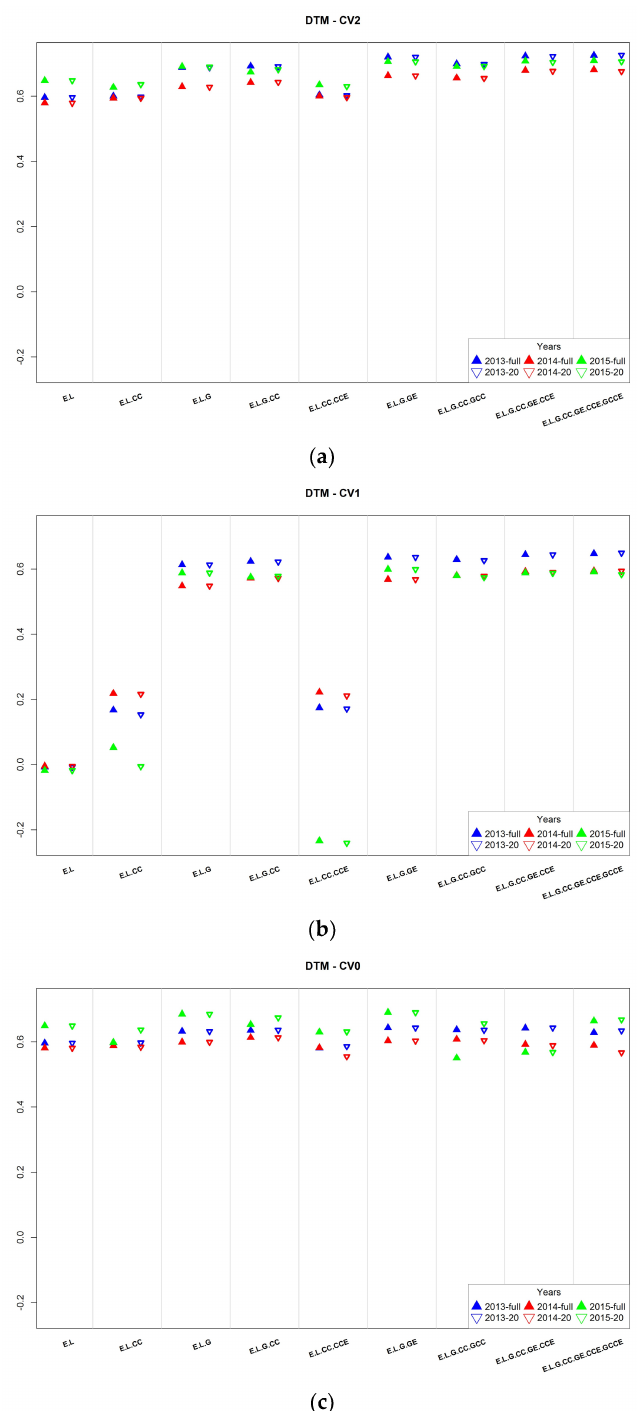
Figure 6. Average prediction accuracy obtained for the nine models for DTM using the CV2 ( a ); CV1 ( b ); and CV0 ( c ) cross-validation schemes for the complete (days 14–71) and reduced (days 14–33) canopy sets. The three different colors represent the years for which the prediction was carried